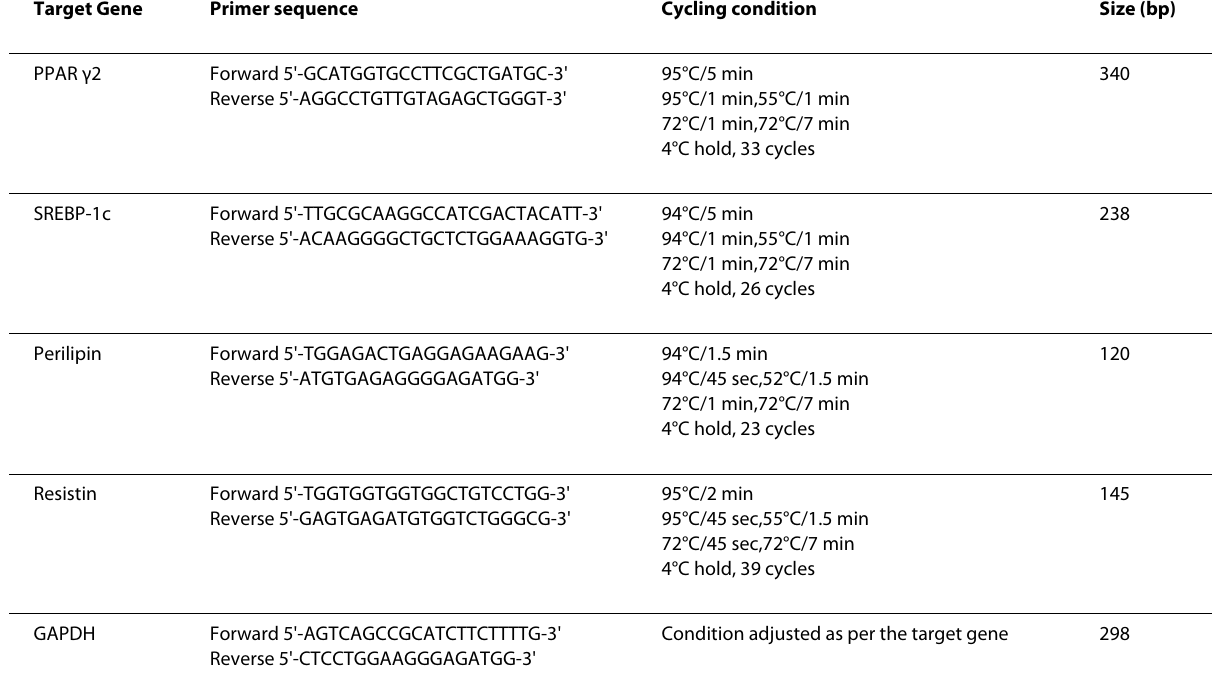
Table 1: Oligonucleotide primer sequences used in RT-PCR Target